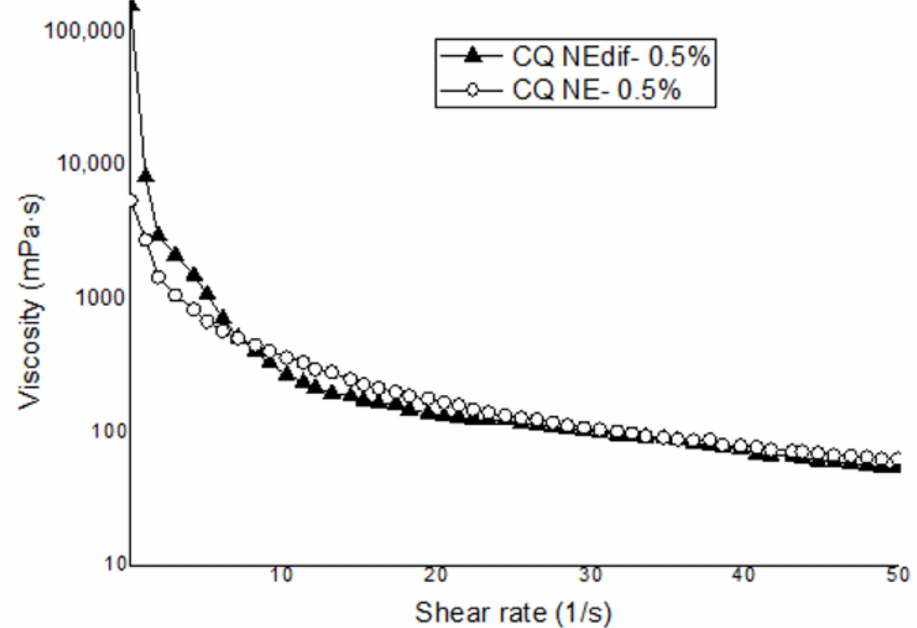
Figure 2. Evolution of the apparent viscosity versus shear rates for the NEs prepared with 0.5% of gelling agent. CQ NEdif- and CQ NE- exposed to the SNF.